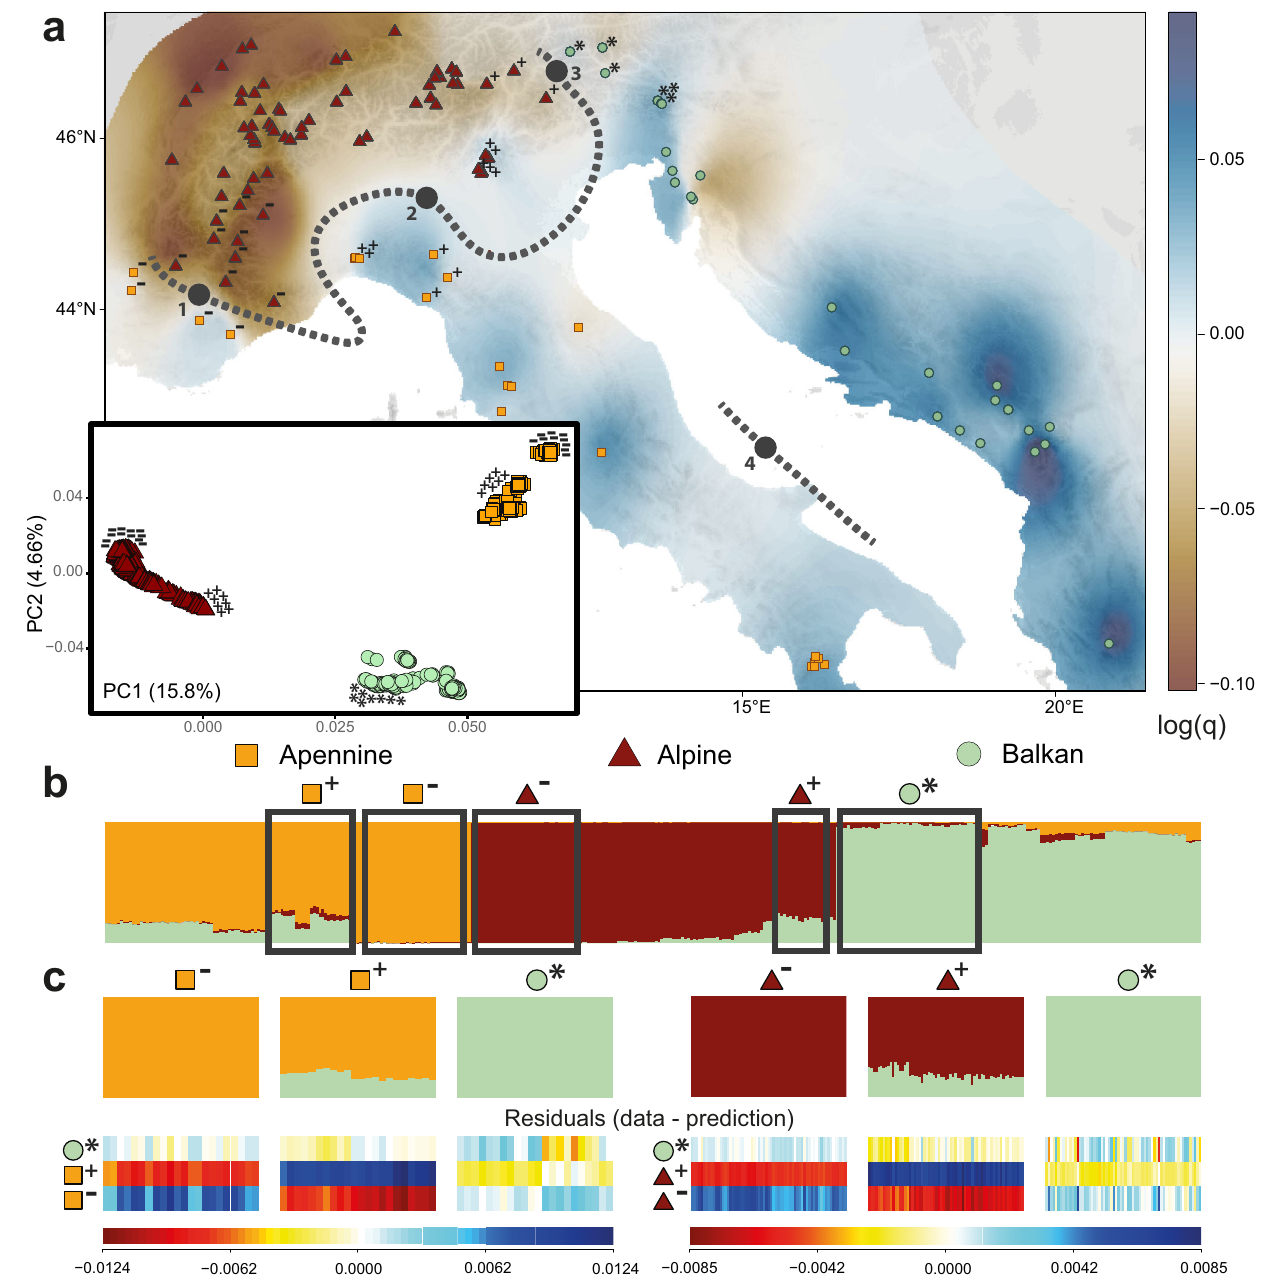
Fig. 2 | D. sylvestris population structure describes genetically and geo- graphically distinct lineages. A Map of sampled populations. Samples are representedascolouredshapesde fi nedaccordingtogeneticcluster,asinferredvia principal component analysis (PCA) of whole-genome sequences (PCA results for all sampled individuals in inset; eigenvalues in axes ’ labels). Landscape colour re fl ects population effective diversity rates ( q ) calculated via EEMS . Thick black dotted lines represent major genetic boundaries as identi fi ed via Monmonier ’ s algorithm on populations ’ F ST . Numbers on line are (1) French Prealps-Maritime Alps boundary, (2) Po Plain, (3) Brenner zone, Puster and Gail valleys, and (4) Adriatic Sea. Plus, minus and asterisk symbols denote individuals and populations at contact zones used in chromosome painting analysis. B Admixture proportions were performed on a balanced dataset comprising a common, down-sampled size of 125 individuals per geographic region to account for known biases related to uneven sampling across clusters 22,23 (Fig. 2B, Supplementary Fig. S3). To visualise the geographic distribution of the three genetic clusters, we